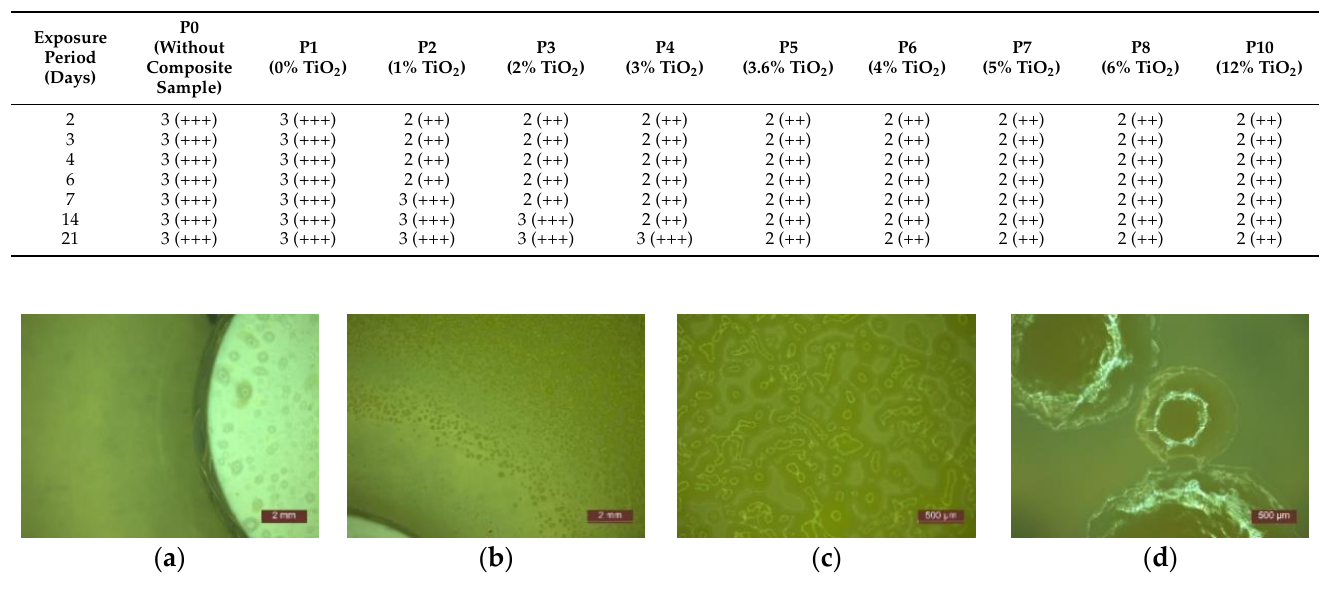
Table 4. Quantification of the microbiological load of the system according to STAS 12718 for samples exposed to Pseudomonas Aeruginosa .